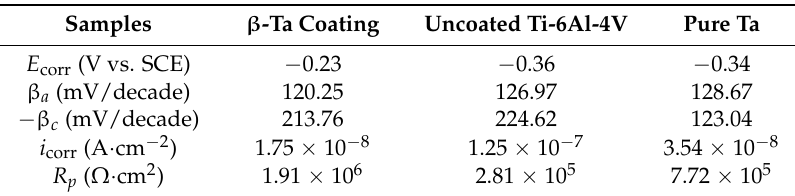
Table 1. Corrosion parameters extracted from potentiodynamic polarization curves of the investigated specimens in Hank’s solution at 37 ◦